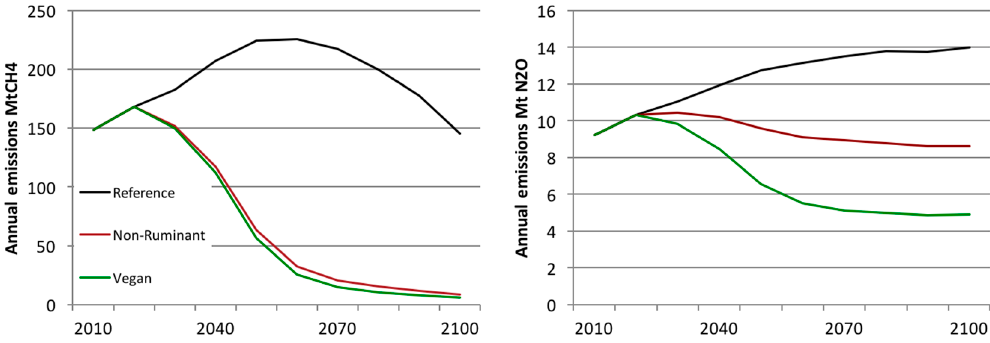
Figure 1. Annual emissions of methane ( left ) and nitrous oxide ( right ) from agriculture for each scenario, as calculated by World Food Supply Model (WOFSUM).